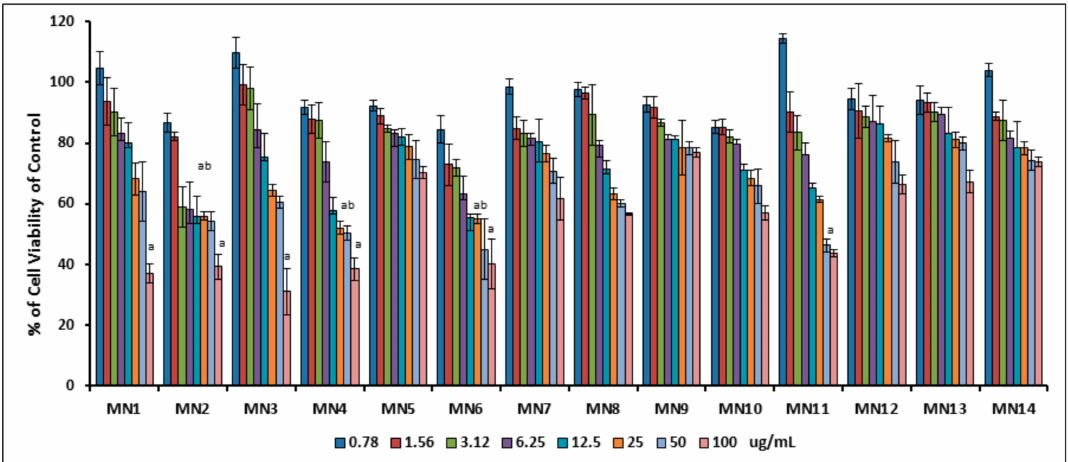
Figure 5. The percentage of cell viability of 3T3-L1 preadipocyte cells measured by MTT assay, ranging from 0.78 to 100 µ g/well for 48 h. Small letters represent Dunnet’s test. Mean ± S.D., n = 3, means values that do not share a letter are significantly different ( p <